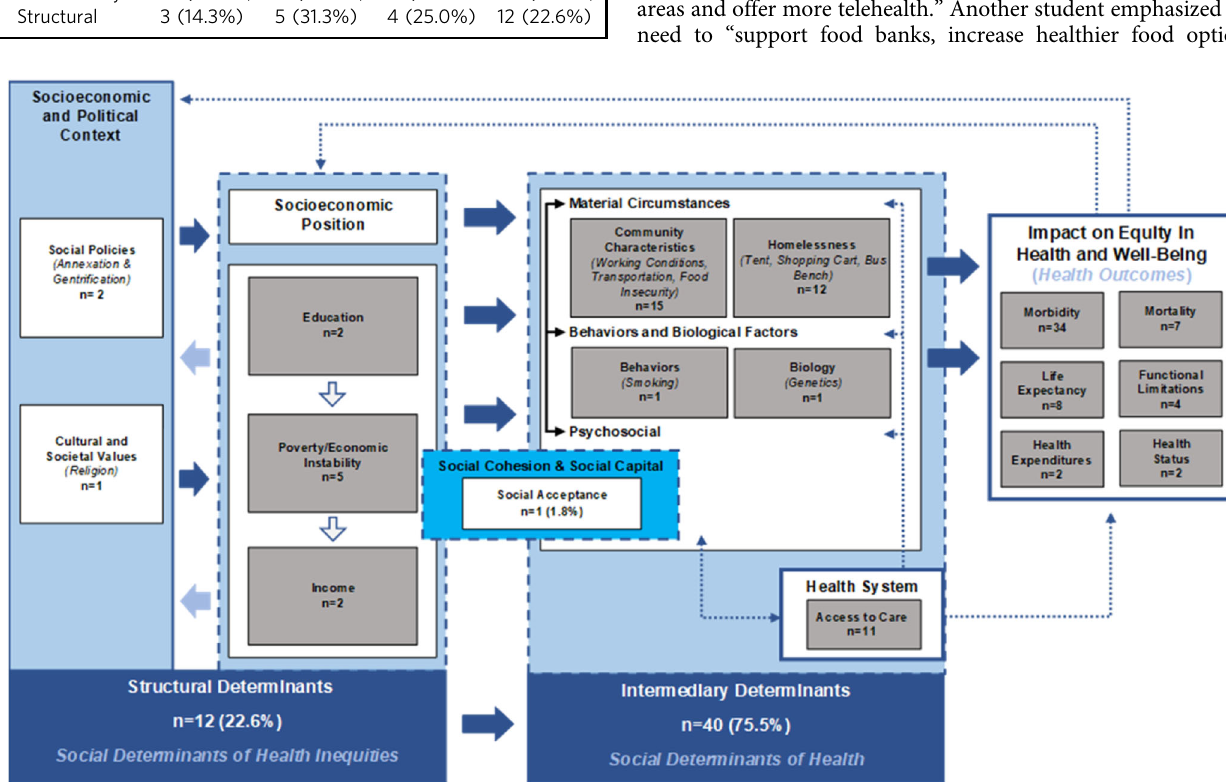
Fig. 1 Depiction of student-identi fi ed SDOH mapped to an adapted Worth Health Organization ’ s (WHO) Commission on Social Determinants of Health (CSDH) conceptual